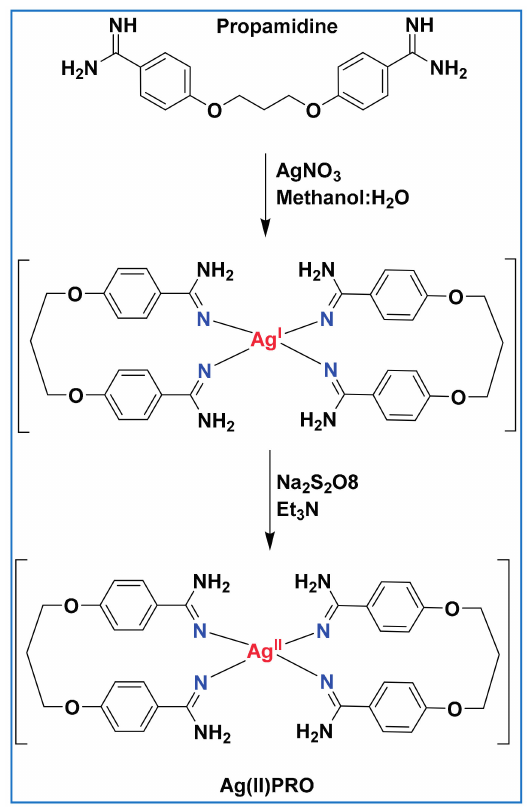
Figure 1. Synthetic scheme for the preparation of silver(II) propamidine complex.